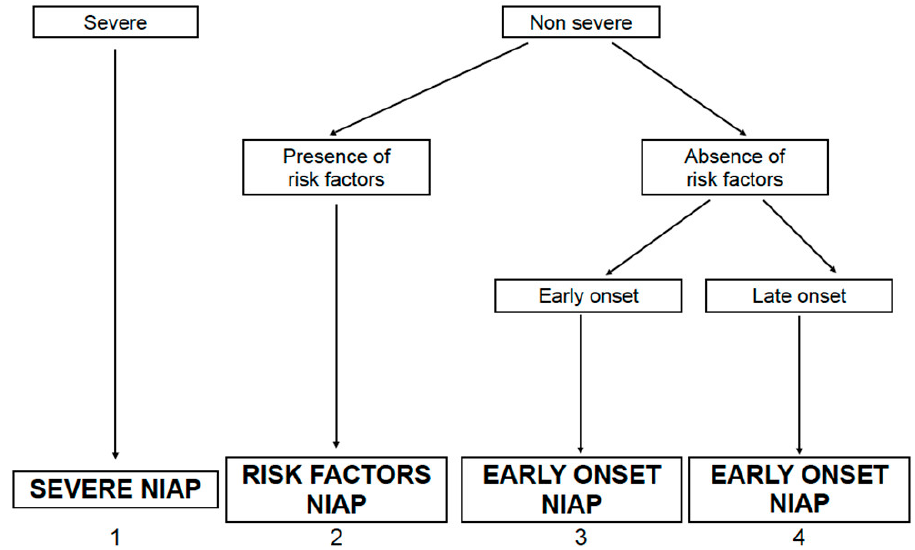
Figure 3. Categories of non ICU acquired pneumonia (NIAP).